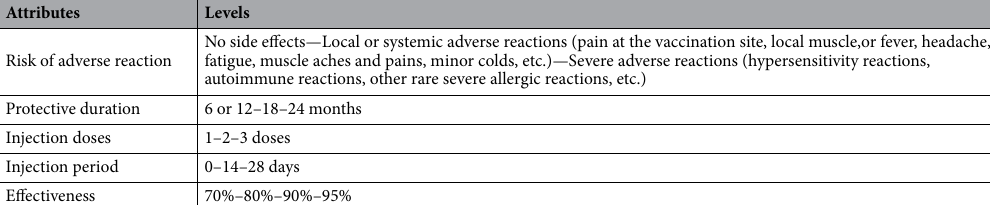
Table 4. Attributes and Levels of the DCE